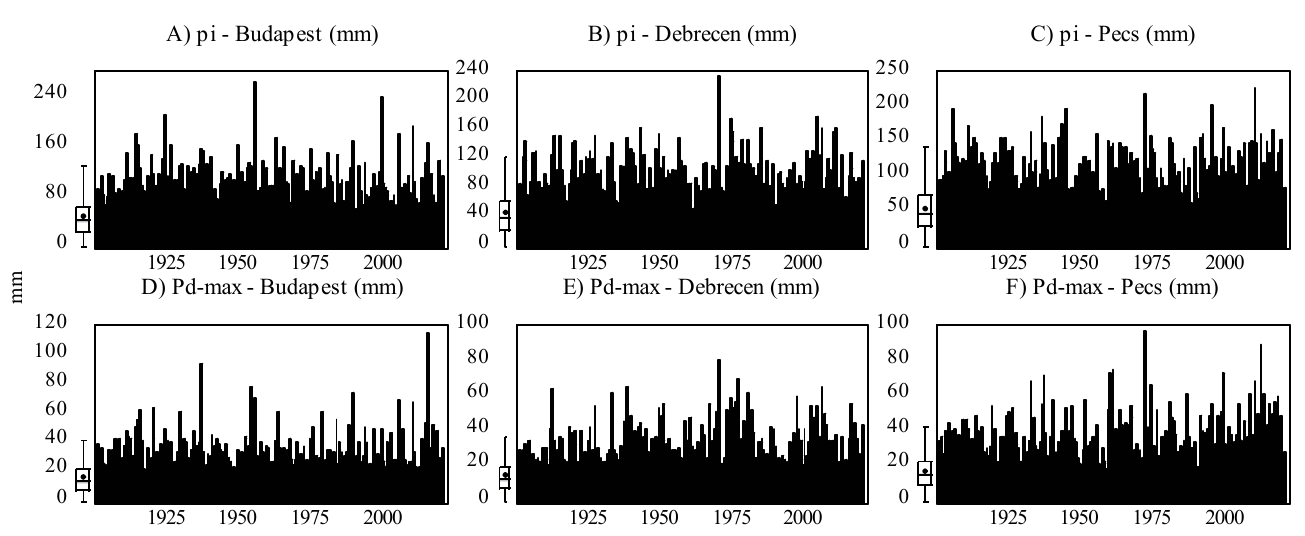
Figure 2. Evolution of monthly rainfall ( p i ) ( A – C ) and daily maximum precipitation ( P d-max ) ( D – F ) in Central Europe (Budapest, Debrecen, Pécs) between 1901 and 2020. Table 4. Descriptive statistical analysis of input variables in three locations, Budapest, Debrecen, and Pécs, between 1901 and 2020.